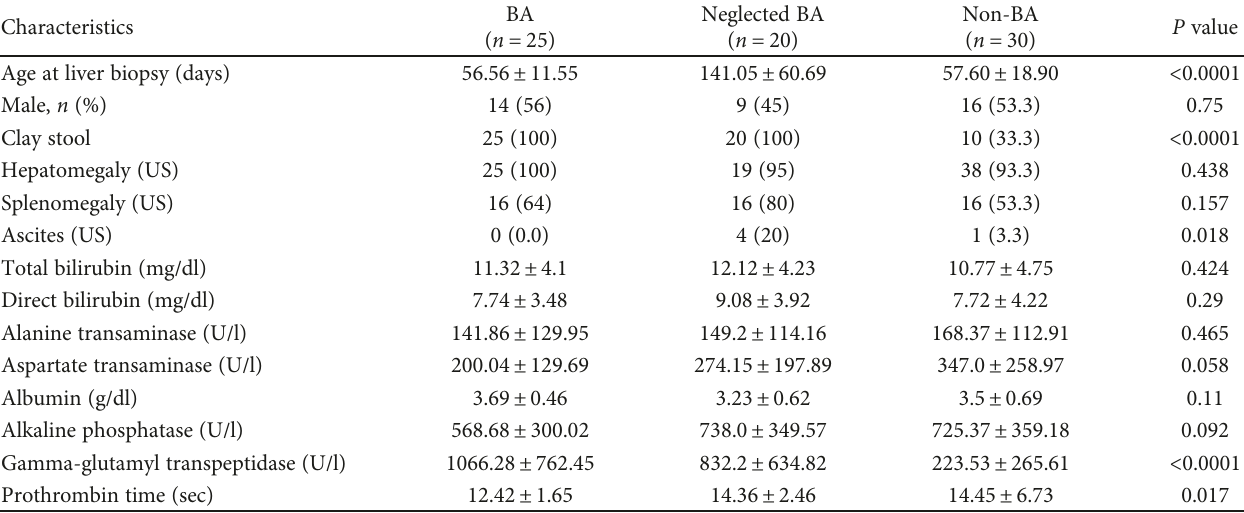
Table 1: Demographic, clinical, and laboratory characteristics of the studied patients.